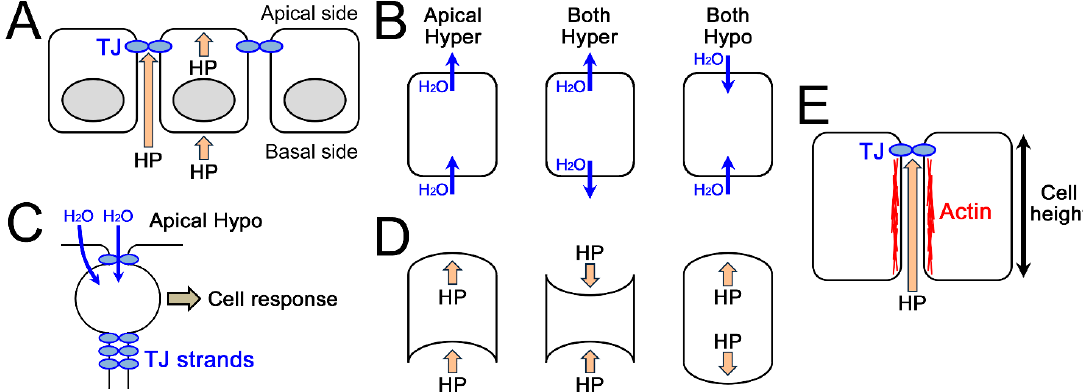
Figure 4. Theoretical speculation of the mechanism about how epithelia sense osmotic and HP gradients. ( A ) A model of epithelium in the HP from basal side. Steep HP gradients are formed at TJs and apical and basal cell membranes. ( B ) The water movement through apical and basal cell membranes in apical hyperosmolality ( left ), hyperosmolality in both sides ( middle ), and hypoosmolality in both sides ( right ). Hyper = hyperosmolality; Hypo = hypoosmolality. ( C ) Possible mechanism of bleb formation between TJ strands in apical hyperosmolality. ( D ) E ff ects of HP from basal side ( left ), increase of HP in both side ( middle ) and decrease of HP in both sides ( right ) on apical and basal cell membranes. ( E ) Possible e ff ects of HP from basal side on F-actin in the lateral side and cell